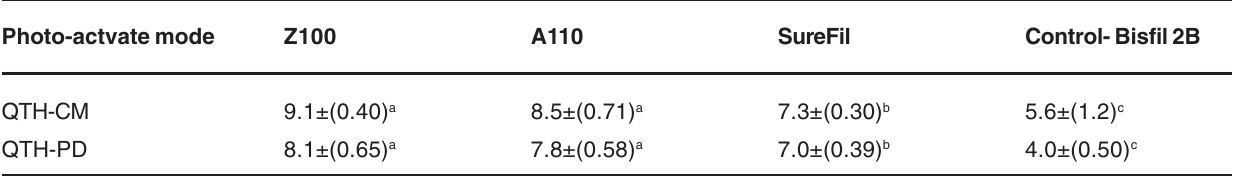
Same letters in horizontal line = no statistically significant difference;